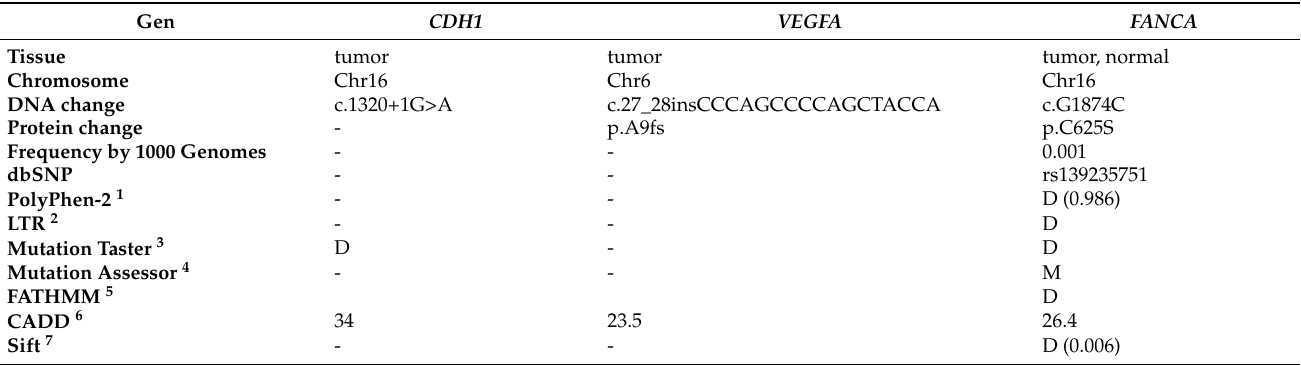
Table 3. Characterization of selected pathogenic mutations.